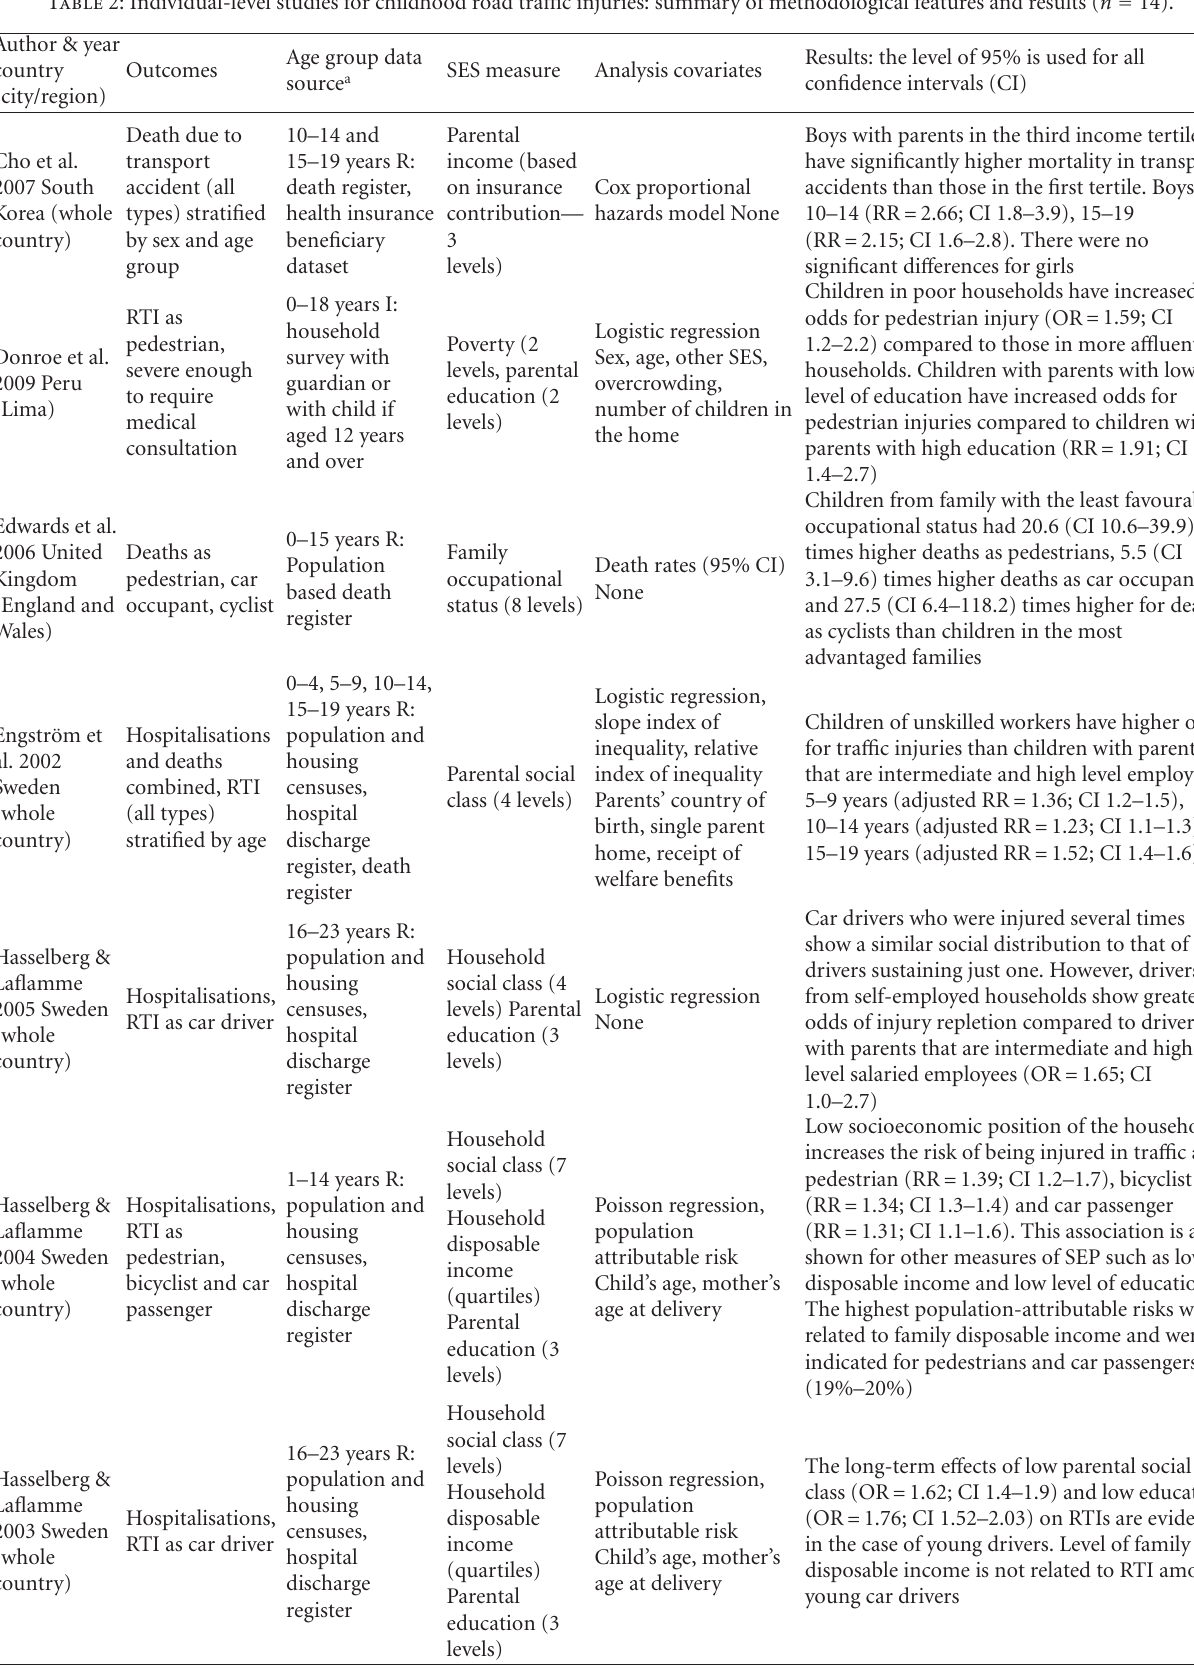
Table 2: Individual-level studies for childhood road tra ffi c injuries: summary of methodological features and results ( n =